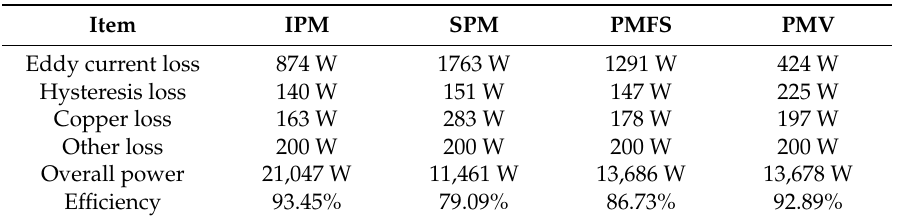
Table 3. Iron Loss of Proposed Six-phase